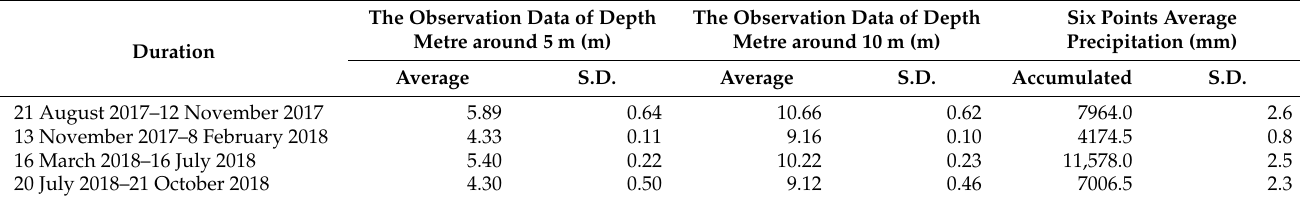
Table A1. Statistical characteristics of input data.